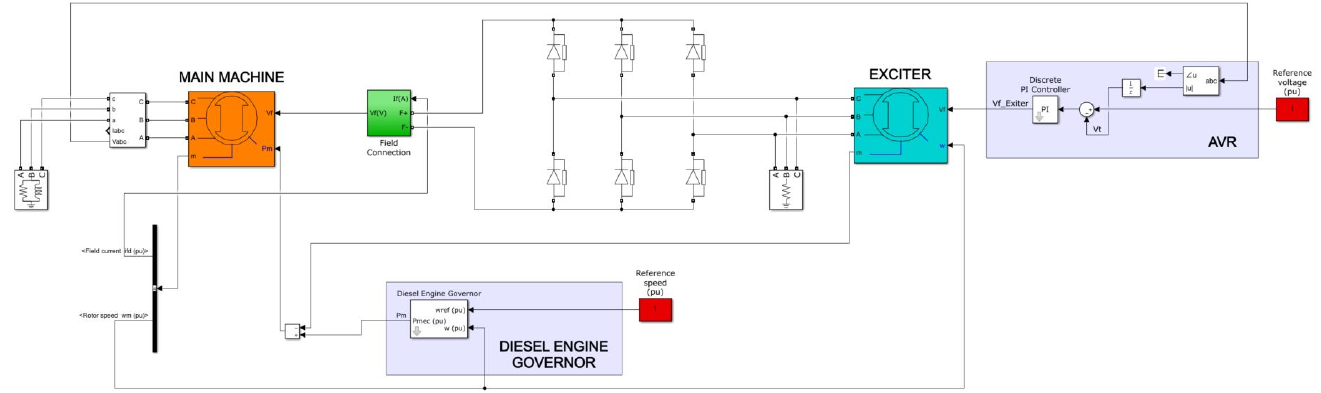
Figure 6. BSM computer simulation model.